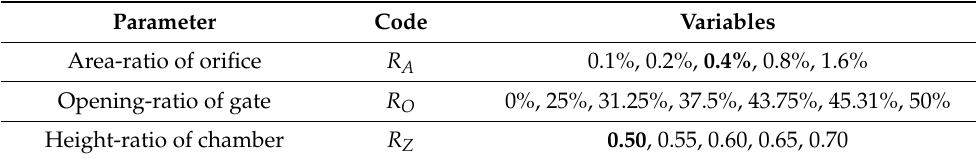
Figure 5. Parameters to be examined in the study: ( a ) Ratio of orifice area R A = A/A w ; ( b ) Ratio of front gate opening R O = O/Z ; ( c ) Ratio of chamber height R Z = Z/h. Table 1. Parameters utilized in the